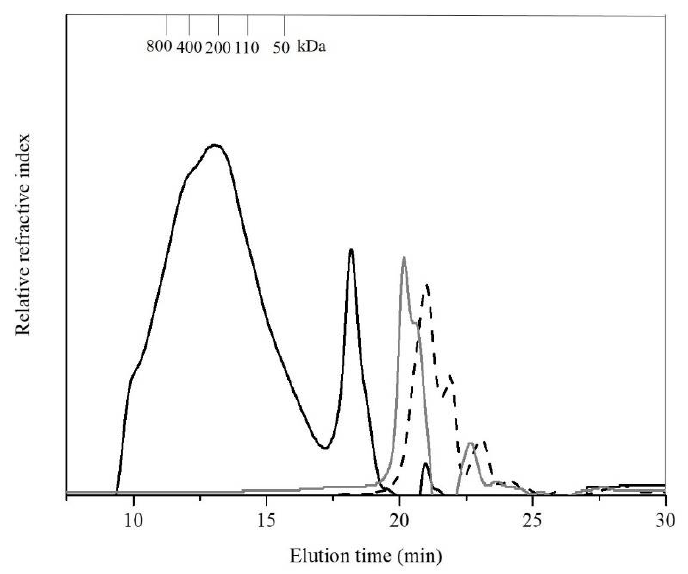
Figure 4. SE-HPLC elution profiles of AX (black line), AX-f (gray line), and basal medium (culture medium with no added carbon source, dotted line). Pullulan molecular weight markers (kDa) used as calibration scales are shown at the top.